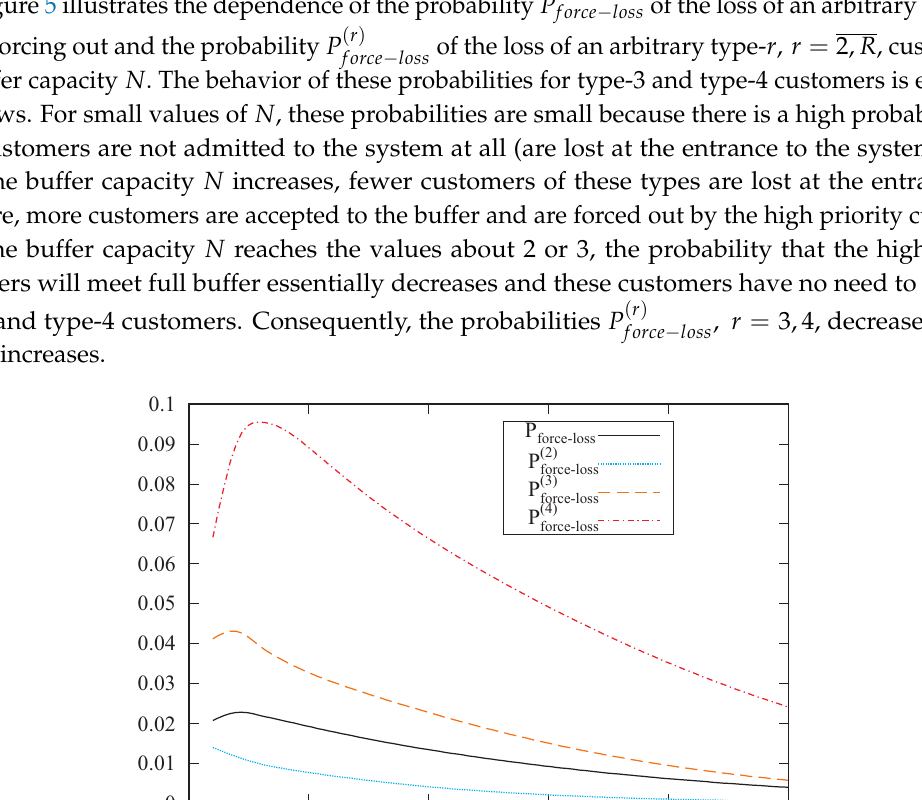
Figure 4. The dependence of the probabilities P ent − loss and P